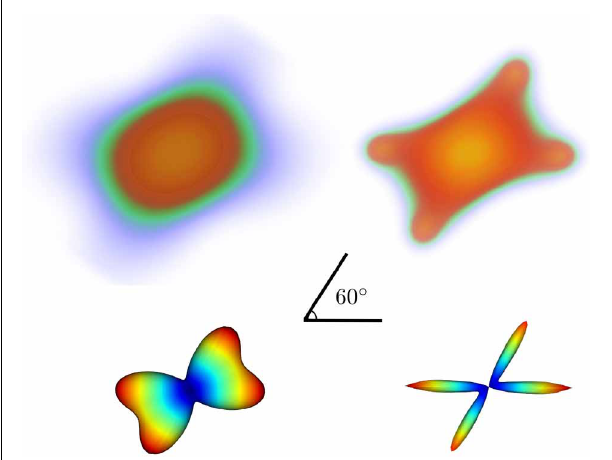
FIGURE 5 | Volumetric rendering of the 3D diffusion propagator of a 60 ◦ crossing with standard DSI (top-left) and DSI with deconvolution (top-right) with their corresponding ODFs